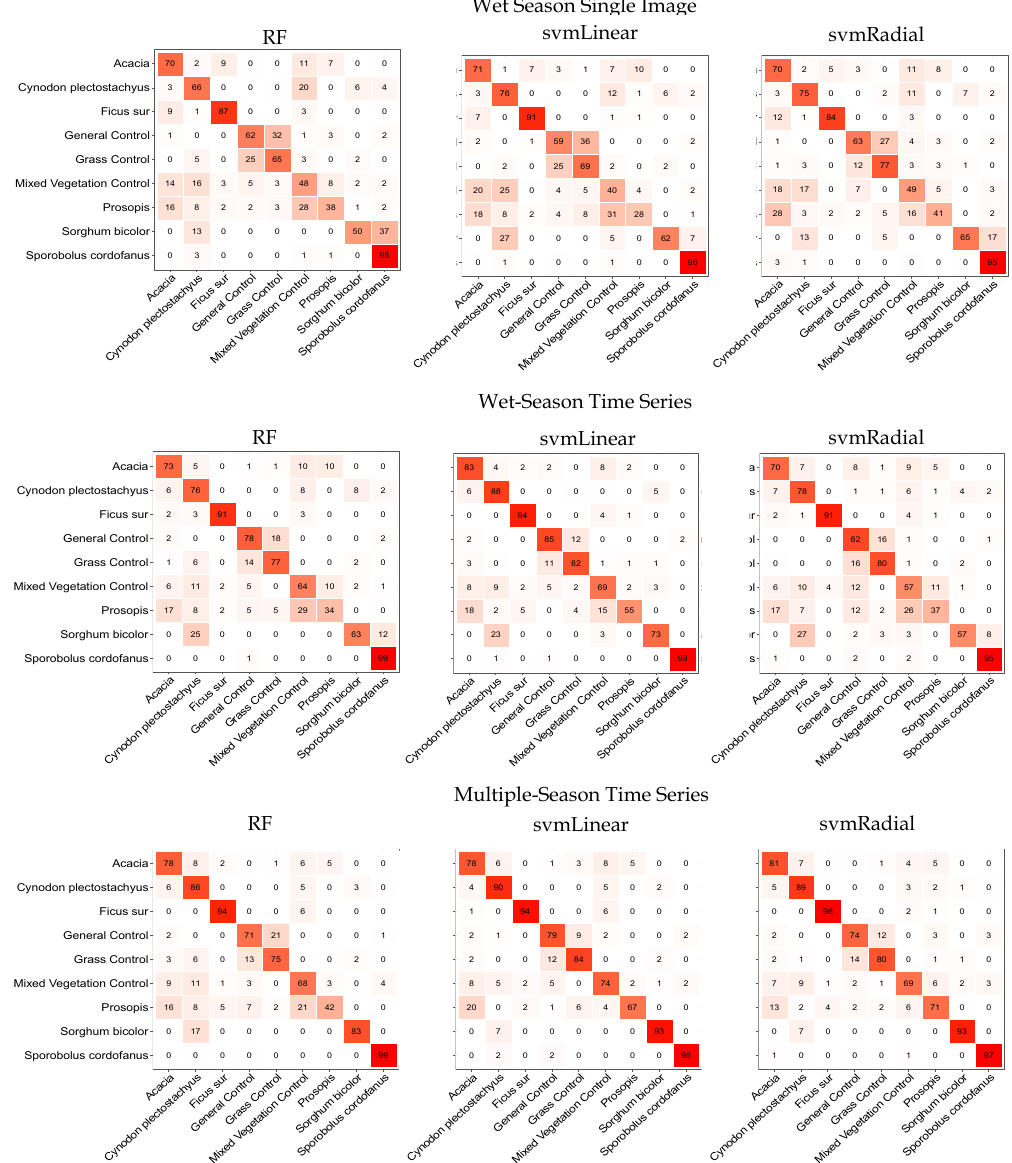
Figure 4. Normalized confusion matrix values for all combinations of classifier and image set. Entries are the percentages of average cell counts from 100 model replicates. A low white to high red color scale was applied to facilitate interpretation.